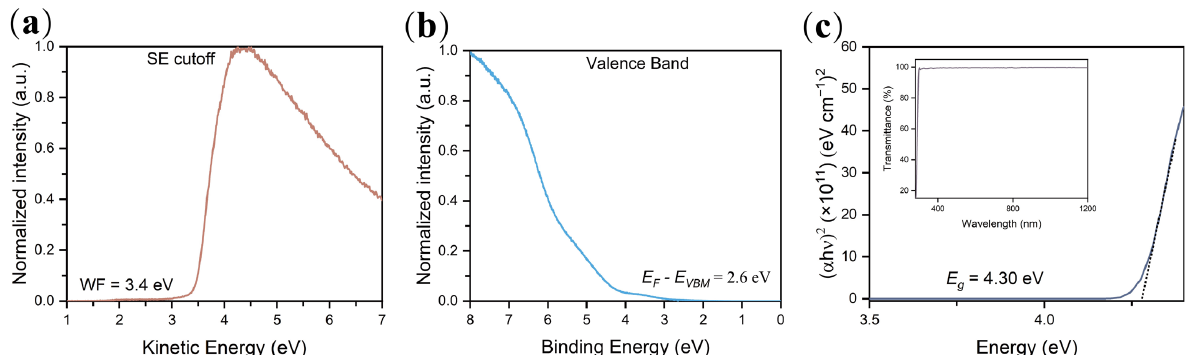
Figure 1. ( a ) UPS measurement results of the secondary electron cutoff spectrum and ( b ) the valence band spectrum of the TX-100 thin film; ( c ) plot of ( α h ν ) 2 against photon energy for the TX-100 film, the transmittance from 180 to 1200 nm is shown in the inset.